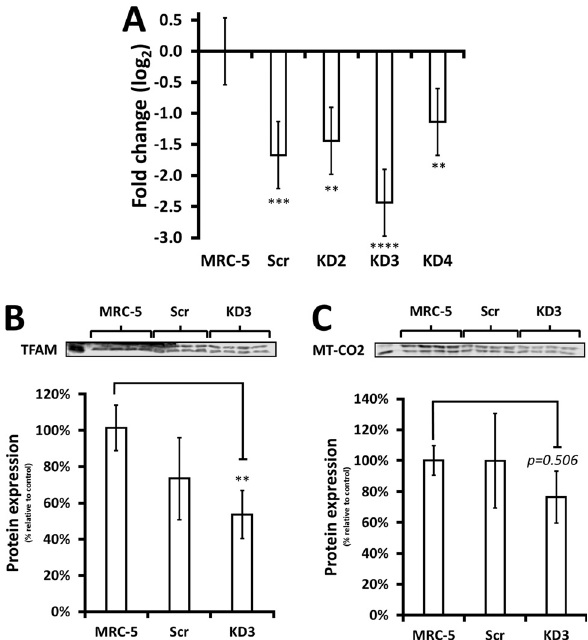
Figure 6 - Analysis of PGC-1 (cid:2) knockdown impact in fibroblasts. A) PGC-1 (cid:2) mRNA expression of MRC-5 fibroblasts untransfected and knockdowncellswereaccessedbyRT-qPCR(mean±SD,n=3).B)Protein levels of TFAM in untransfected MRC-5 cells (MRC-5), transfected scramble shRNA MRC-5 cells (Scr) and transfected PGC-1 (cid:2) knockdown MRC-5 cells (KD3). C) Protein levels of MT-CO2 in MRC-5, Scr and KD3 cells (mean±SD, n=4). MRC-5 was set as reference (100%). ** p <0.01, *** p <0.001 and **** p